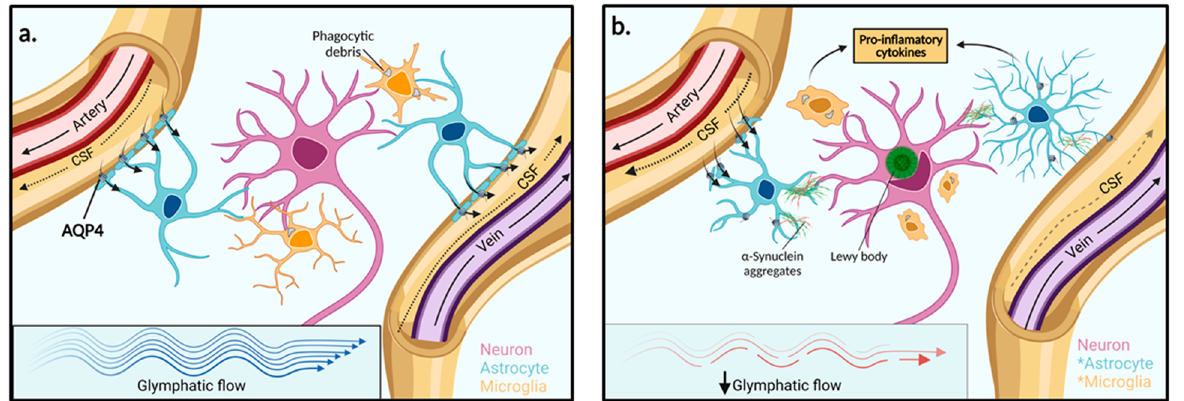
Figure 2. Function of the glymphatic system in extracellular solute clearance. ( a ) The subarach- noid space feeds CSF into the periarterial space of surface and penetrating cerebral arteries. The parenchymal ISF facilitates solute clearance via passage into the postcapillary vasculature. Flow is then directed back through the perivenous space towards the subarachnoid space via cerebral surface veins or cervical lymphatic drainage. In the interstitium, astrocytes line the vasculature with end-feet processes that express AQP4 channels in high concentration. ( b ) In PD, reduced glymphatic clearance may lead to the accumulation of extracellular α -synuclein aggregates and other solutes. Neighbouring neurons may then take up protein aggregates and facilitate the spread of Lewy body pathologies towards adjacent brain regions. The presence of aggregated α -synuclein within the extracellular space stimulates astrocyte and microglia activation to pro-inflammatory phenotypes and enhanced pro-inflammatory mediators. AQP4: Aquaporin 4, *: Activated cell type.